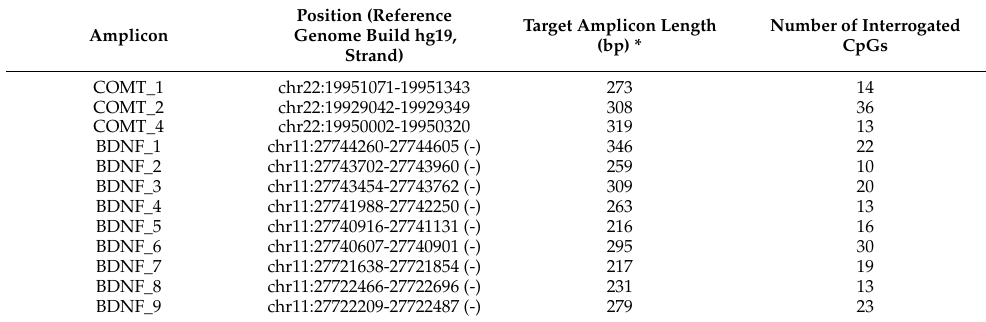
Table 1. The amplicon positions and lengths and the number of CpGs for the BDNF and COMT genes. Position (Reference Target Amplicon Length Number of Interrogated Amplicon Genome Build hg19, (bp) * CpGs Strand) COMT_1 chr22:19951071-19951343